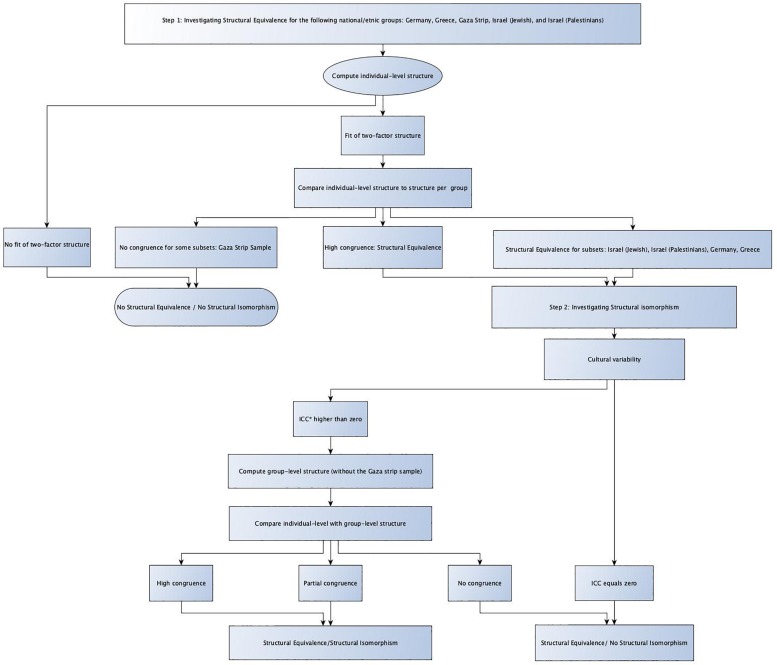
Overview of steps for the analysis of structural equivalence and structural isomorphism (Fischer and Fontaine, 2010; Fontaine and Fischer, 2010). ∗ICC = Intra-class correlation.